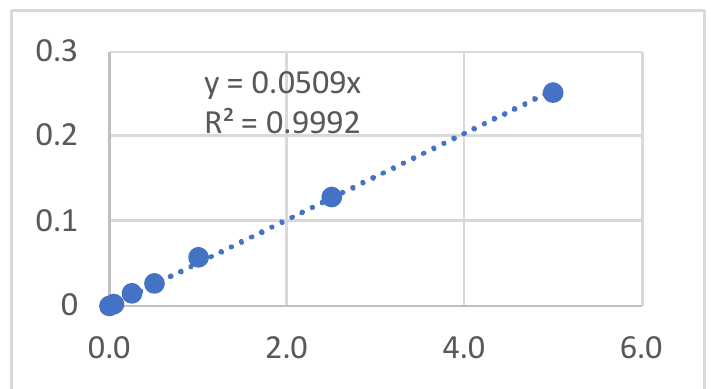
Figure 2. Cr calibration graphs.